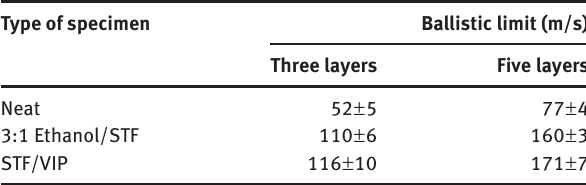
Table 2 Experimental results by gas gun for three and five layers of